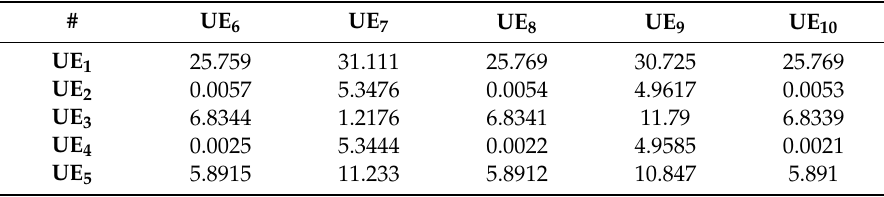
Table 2. User pairing description in Hungarian algorithm for energy e ffi ciency